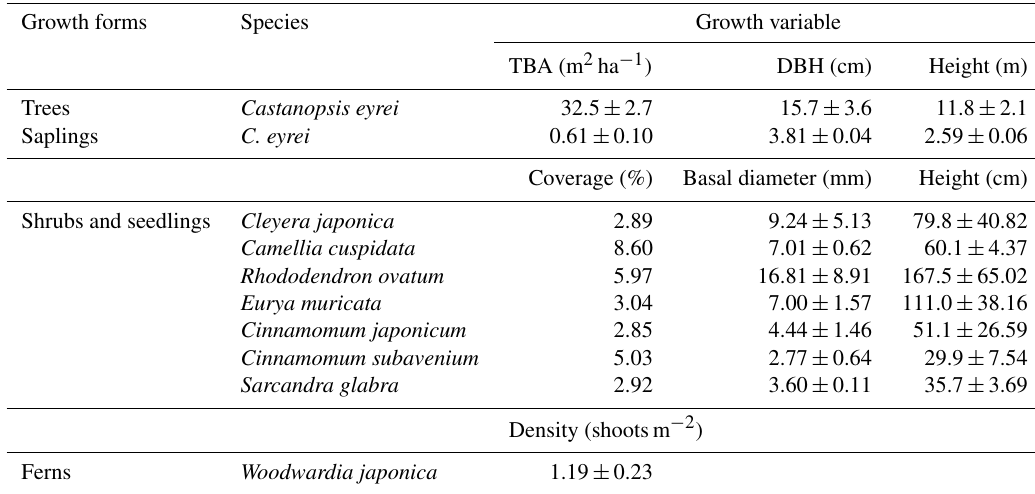
Table 1. Growth measurements for four plant growth forms in this study before N fertilization. Numbers in the tables represent means (or mean ± standard error, n = 9) of plants across all plots. TBA: total basal area of trees; DBH: diameter at breast height (1.3m); Basal diameter: diameter at 10cm above the